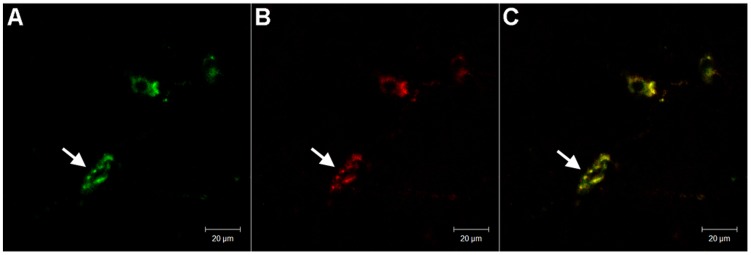
Co-expression of ASIC1 and OrexinA in the LH of adult SD rats.A representative confocal photomicrograph showing co-staining of orexinA and ASIC1 on neurons in the LH of an adult SD rat. A: OrexinA-ir neurons (green, FITC). B: ASIC1-ir neurons (red, cy3). C: Overlay of A and B.